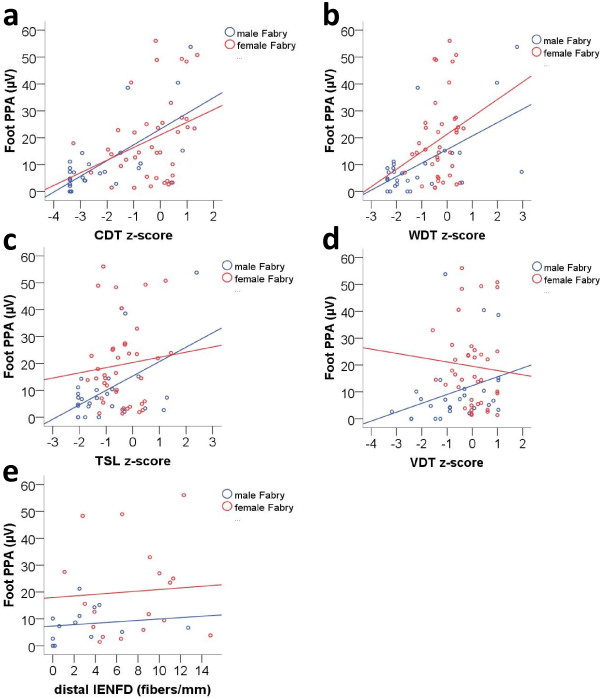
Correlations of sensory profile and nerve fiber density with pain-related evoked potential amplitudes. Scatter plots show correlations between PREP peak-to-peak-amplitudes (PPA) recoded after stimulation at the feet and QST parameters (warm detection threshold, WDT; cold detection threshold, CDT; thermal sensory limen, TSL; vibration detection threshold, VDT). a) PREP PPA correlated positively with CDT in male (correlation coefficient: 0.564, p = 0.002) and female Fabry patients (correlation coefficient: 0.340, p = 0.034). b) PREP PPA correlated positively with WDT only in male Fabry patients (correlation coefficient: 0.390, p = 0.04). c, d) TSL and VDT did not correlate with PREP PPA in either gender. e) Distal IEFND did not correlate with PREP PPA obtained after stimulation at the foot.